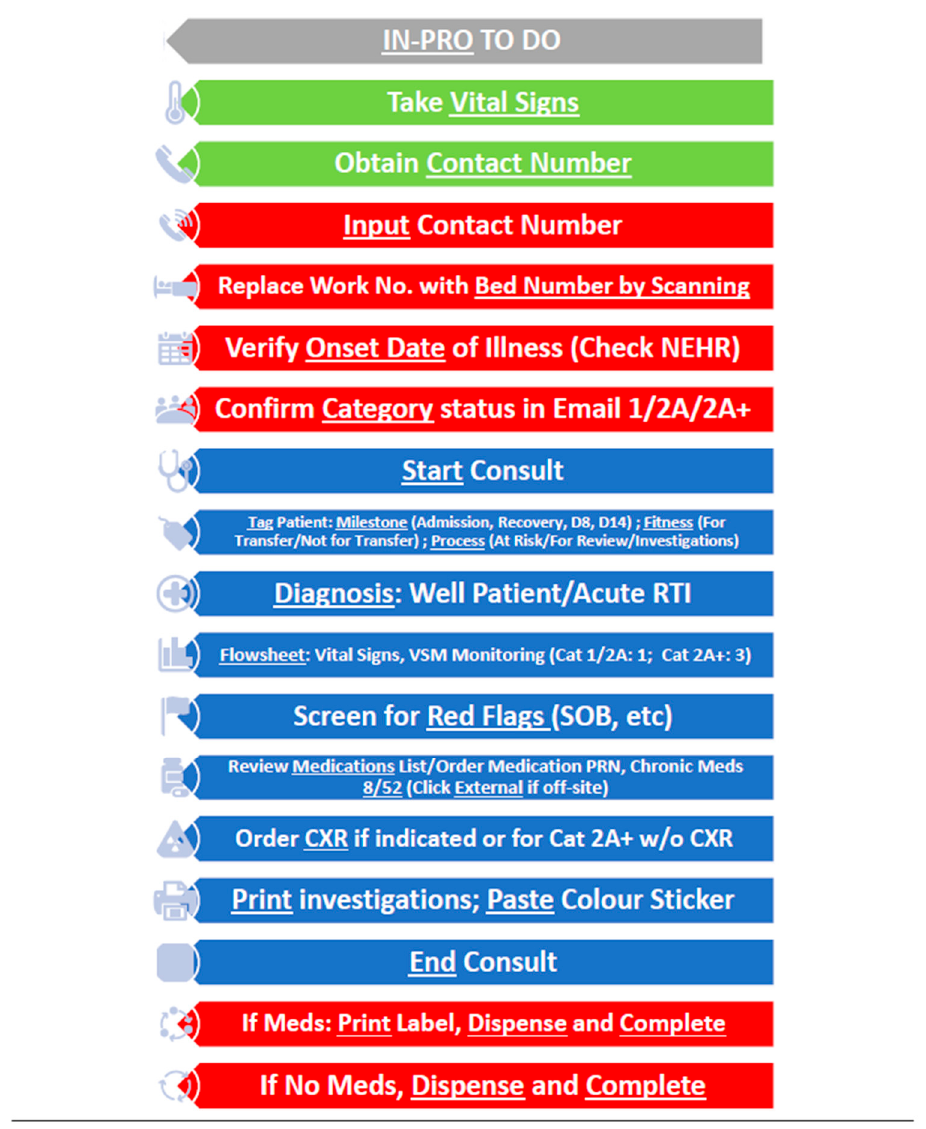
Figure 5. Visual cue charts at In-Pro. Legend: green: nursing tasks; red: clinic management system tasks; blue: electronic medical record tasks.